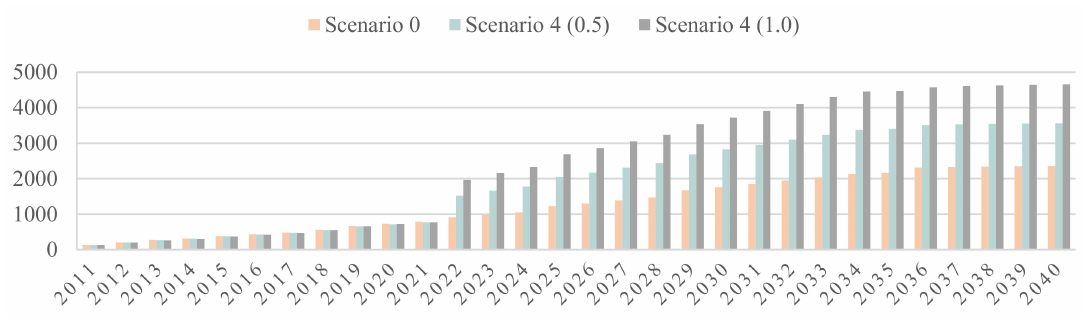
Figure 10. Comparison between Scenario 0 and Scenario